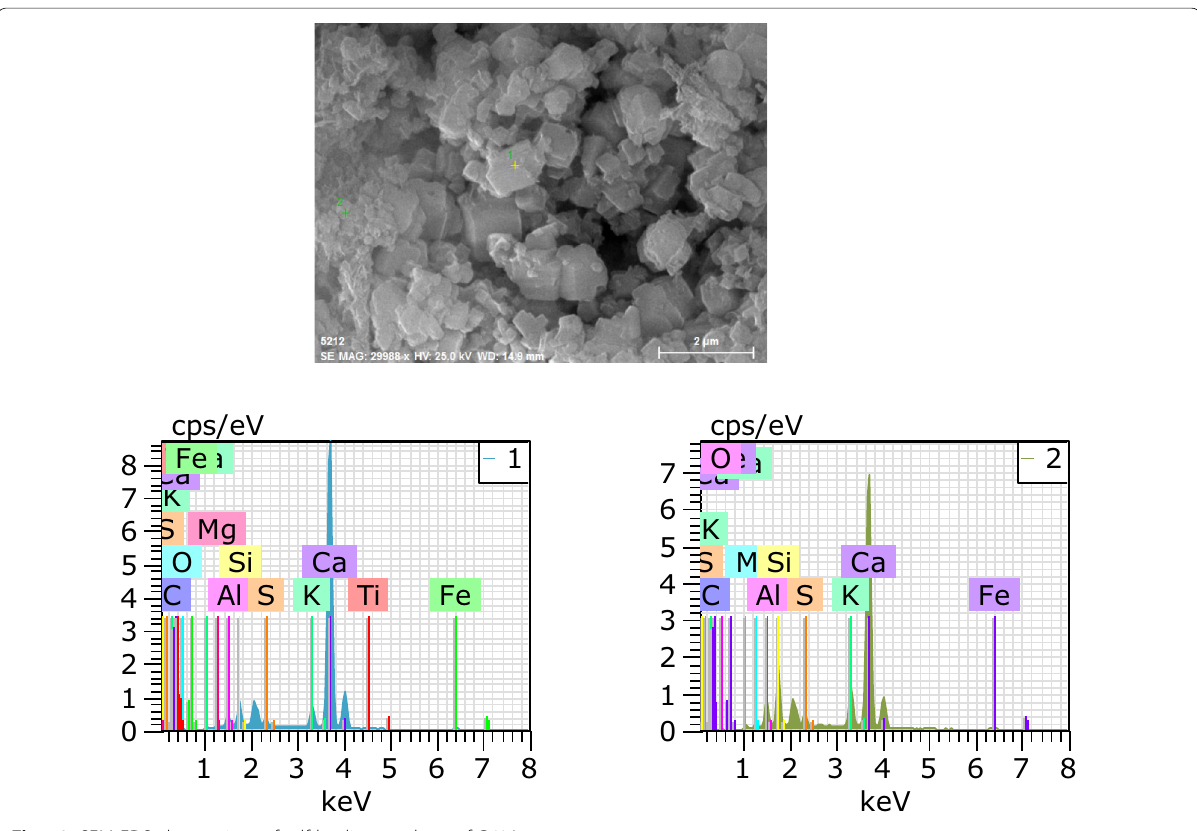
Fig. 13 SEM-EDS observations of self-healing products of